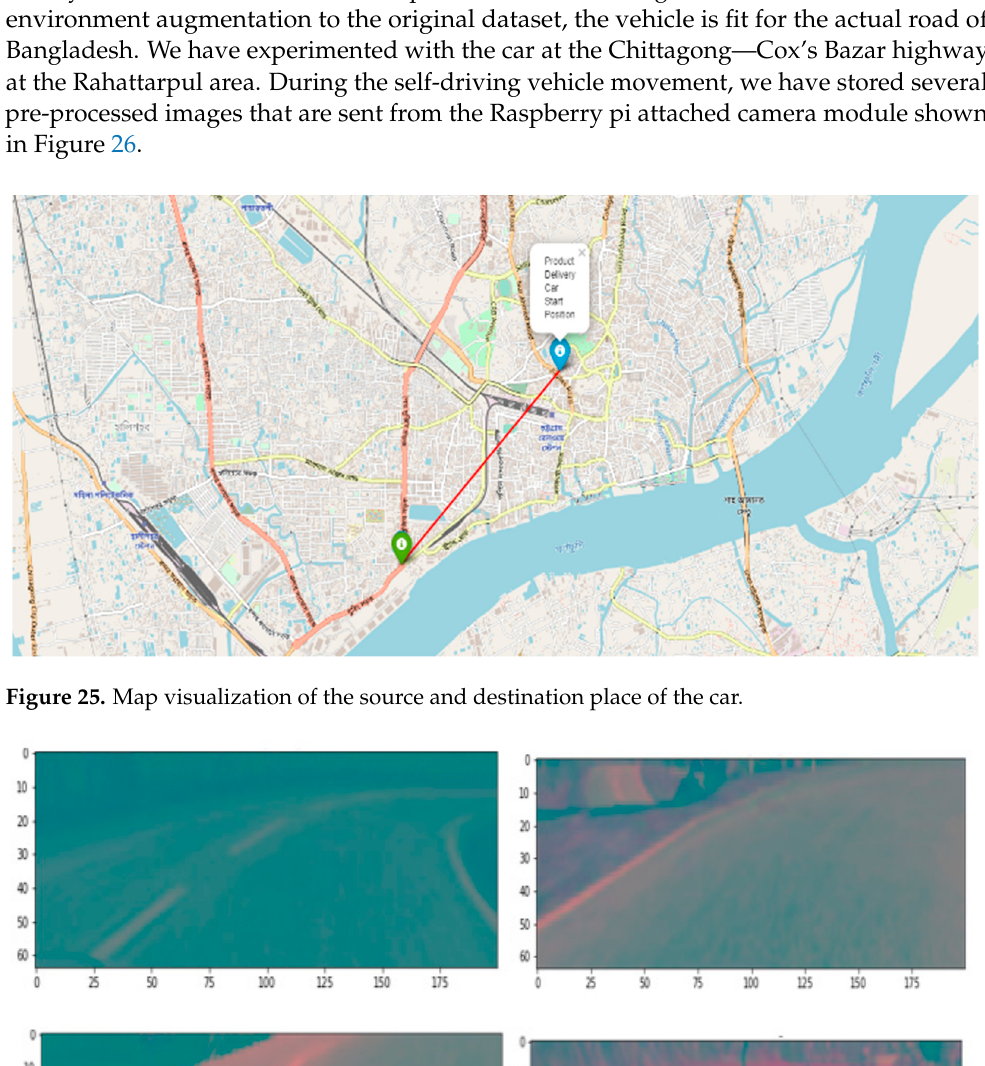
Figure 24. Map visualization of the geographical position of the car.